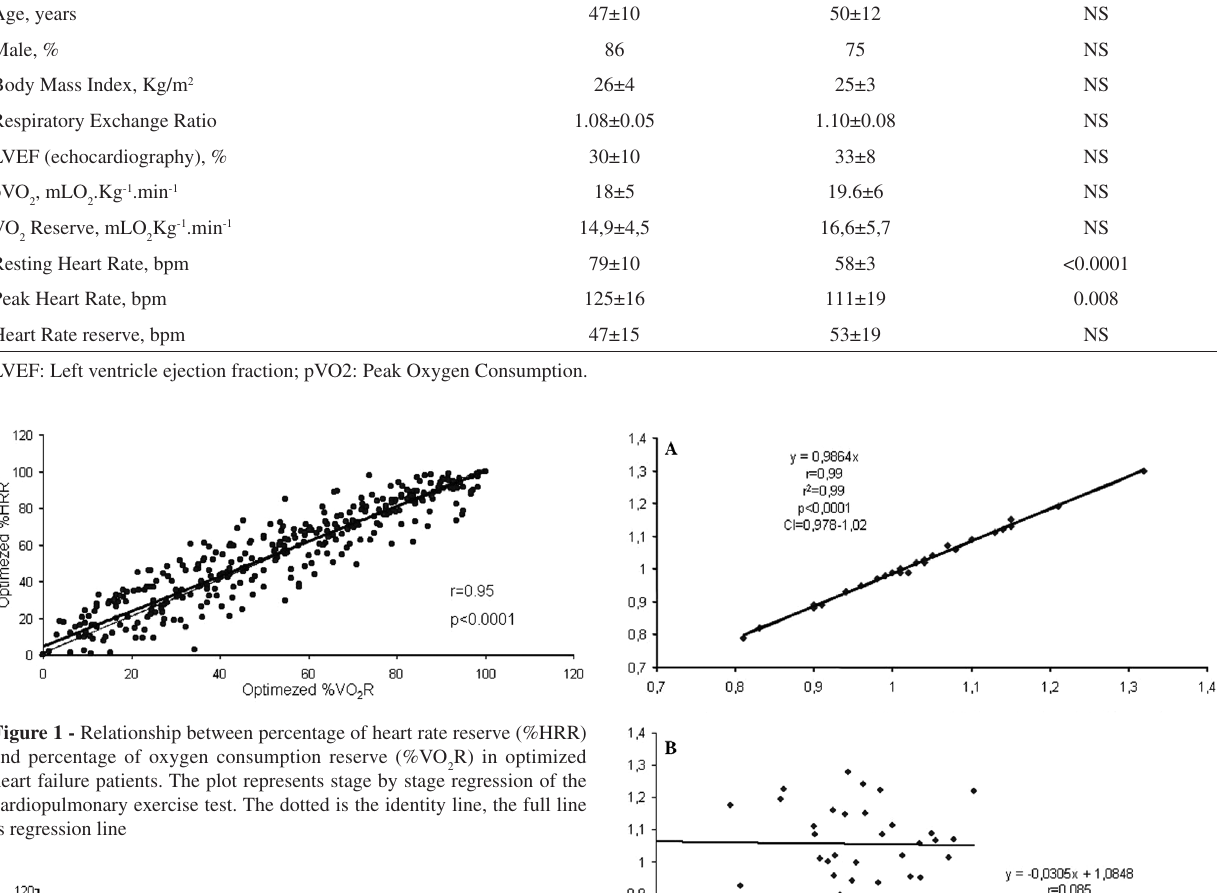
Table 2 - Characteristics of the heart failure patients